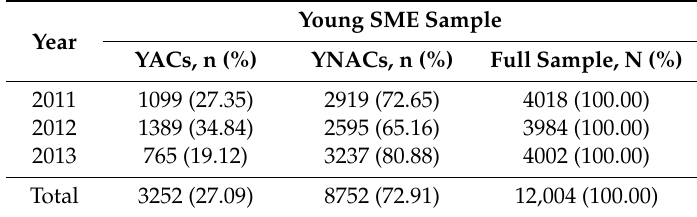
Table 2. Distribution of sample of young SMEs, 2011–2013.